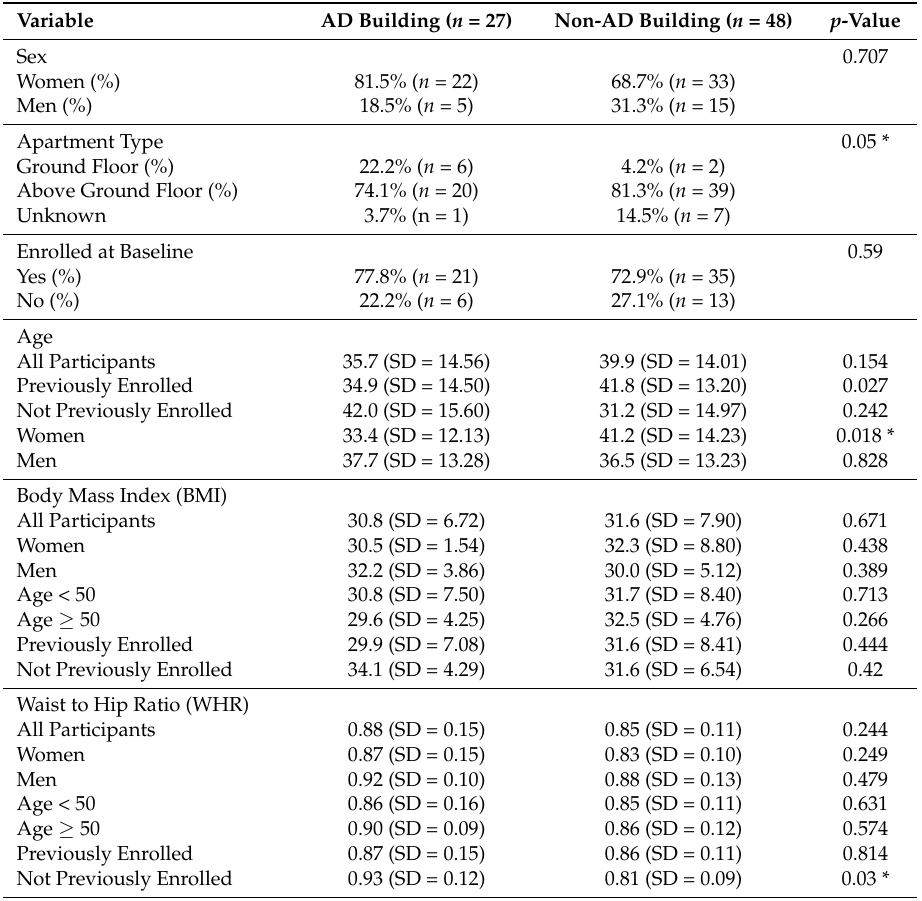
Table 4. Stratified Cross-sectional One Year (T1) Anthropometric and Demographic